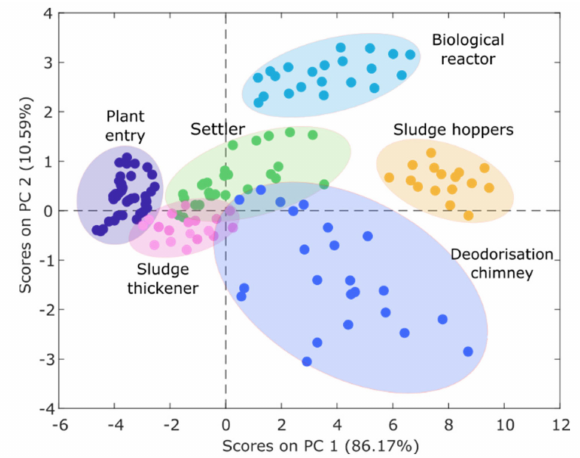
Figure 8. Principal component analysis (PCA) score plot of the e-nose